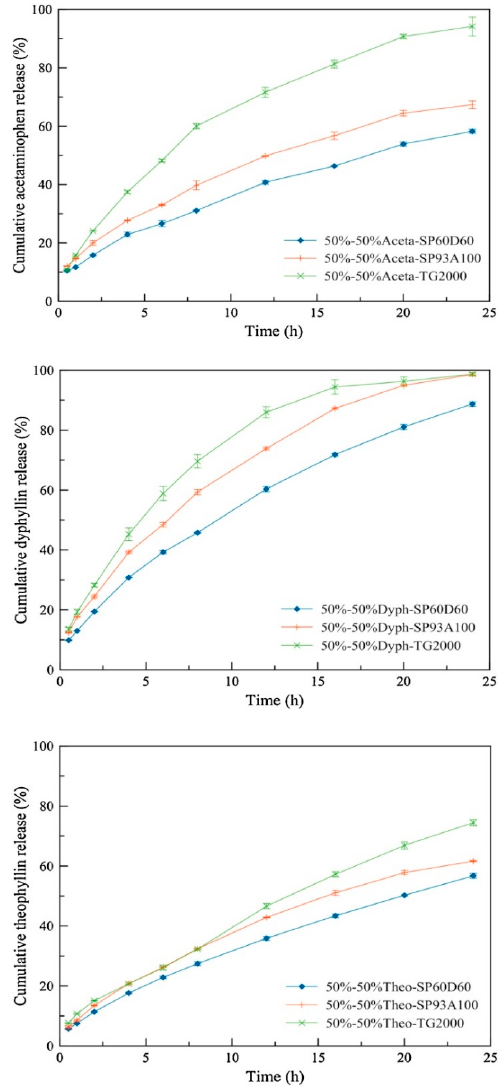
Figure 5. Influence of length of the polyurethane soft segment (polyethylene oxide) on the in vitro release kinetics of drugs with different aqueous solubility (acetaminophen, diprophylline and theophylline) from polyurethane-based matrices (SP60D60, SP93A100 and TG2000). Adapted from reference [74], Elsevier, 2016 with permission.